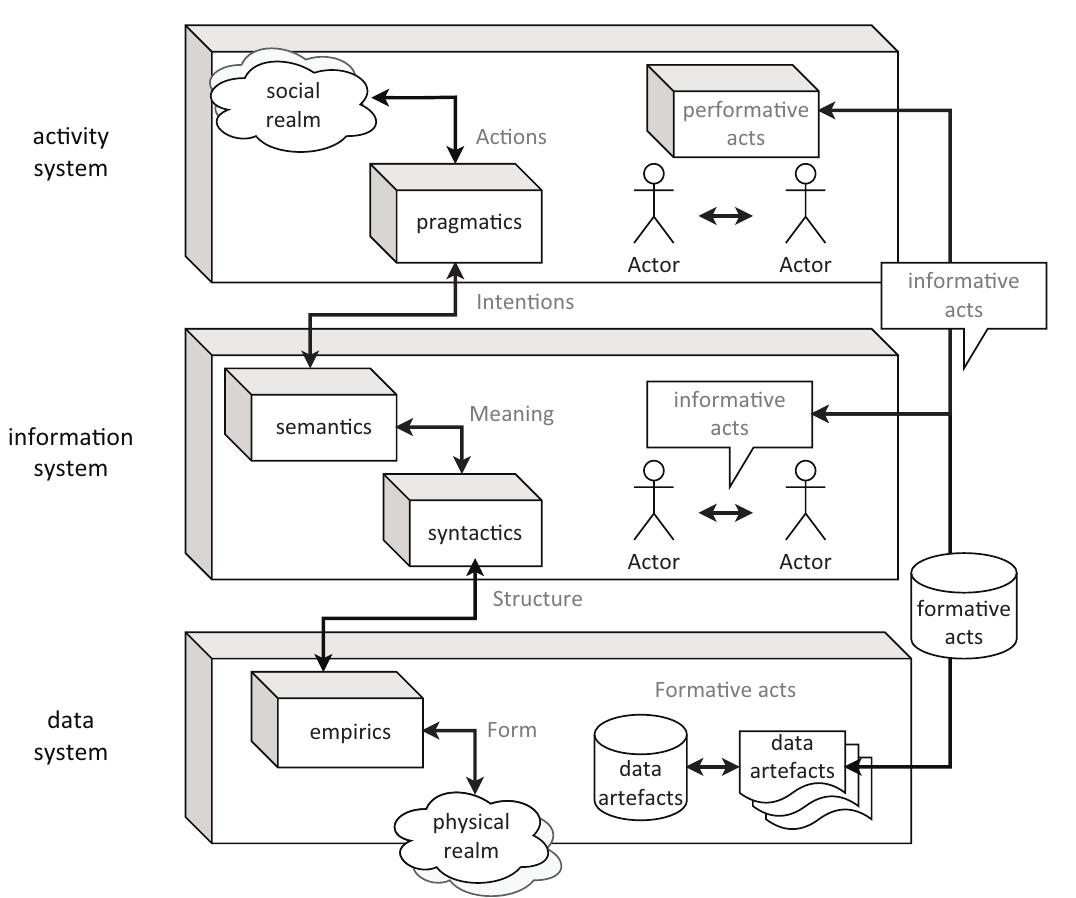
Figure 2. Conceptual framework for the enactment of significance through technology. Source: Adapted from Beynon‐ Davies (2010, p.